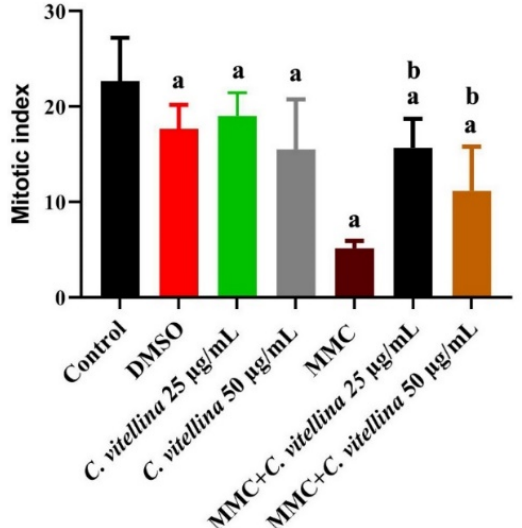
Figure 5. A histogram showing the protective effect of C. vitellina extract on HPBL mitotic indexes, 24 h against MMC-induced division arrest, showing significant differences at ( p ≤ 0.05) with respect to untreated (a) and MMC-treated (b) groups. Data were represented as (Mean ± SD) of three different experiments (n = 3). MMC: Mitomycin C (0.5 µg/mL).